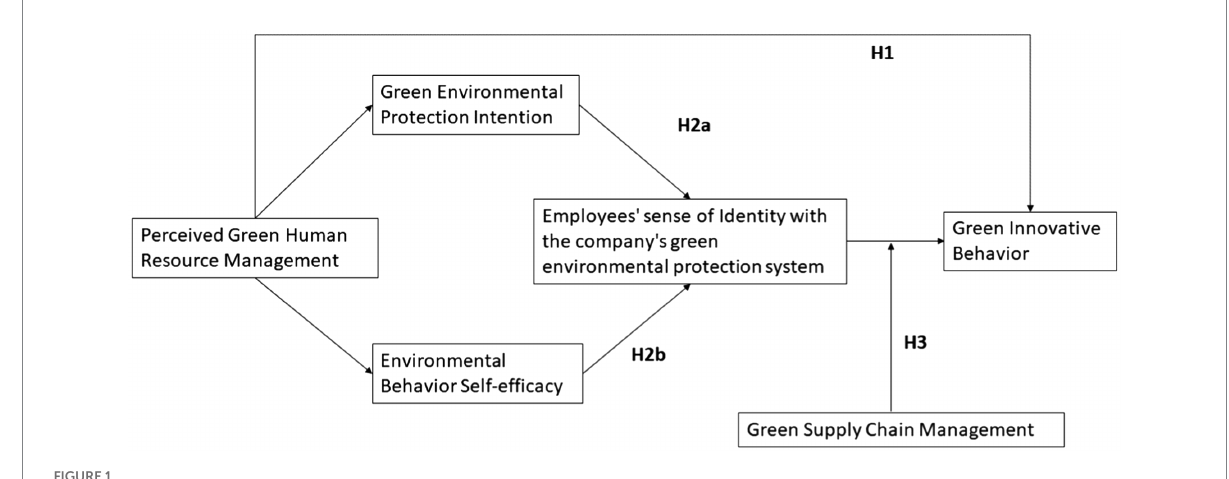
FIGURE 1 Research framework.